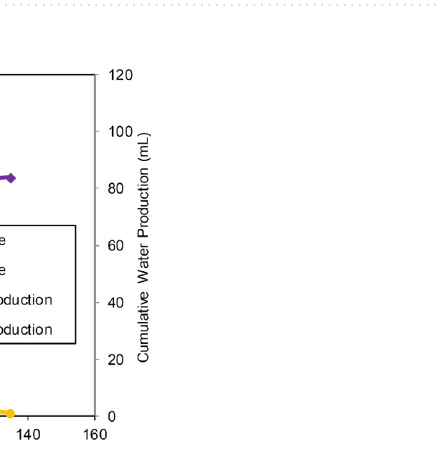
Figure 12. Gas production of two wells in Experiments 2-1 and 2-2: ( a ) gas production of Well 1 located in the MZ, and ( b ) gas production of Well 2 located in the FZ.